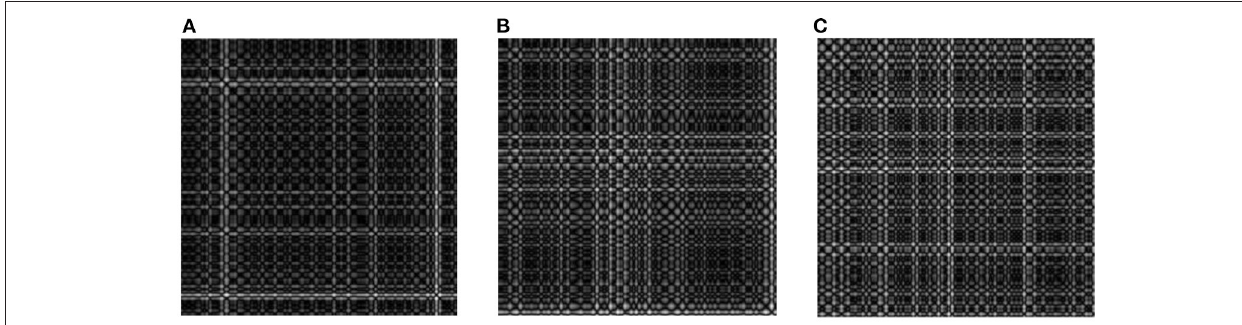
FIGURE 3 | Alzheimer’s disease recurrence plot. (A) Calm. (B) Morbidity. (C) Transitional period.